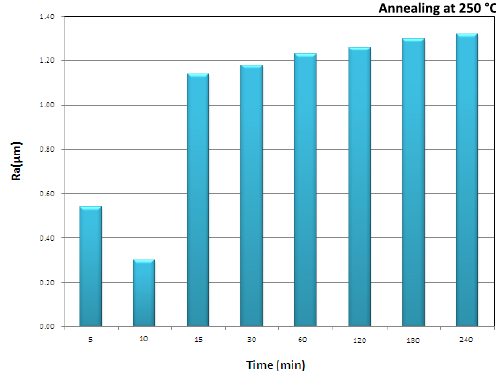
Figure 6. Surface roughness of the samples annealed at 250 ◦ C at different